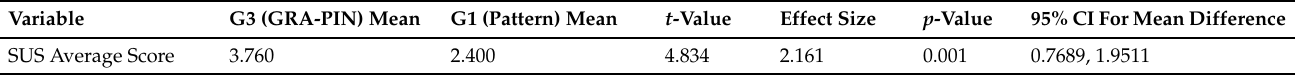
Table 5. T -test evaluation for G1 and